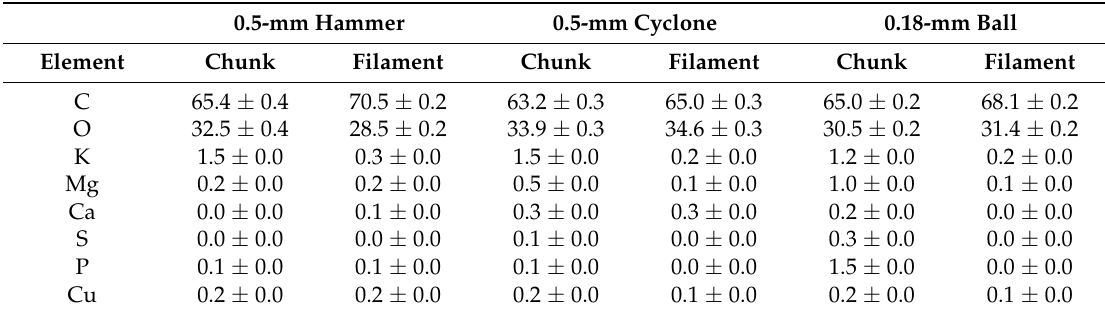
Table 1. Elemental composition (% atom ± δ ) of the cuboid- and filament-like particles of WCSM products by SEM-EDS